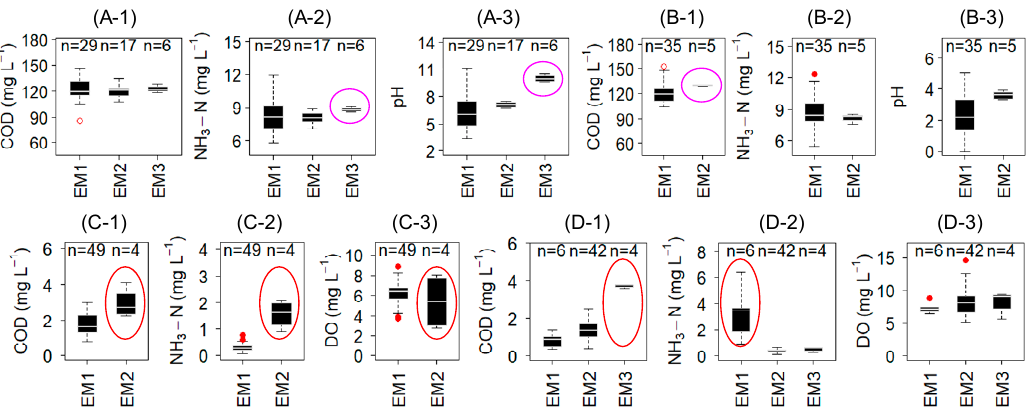
Figure 8. EM clustering classifications of discharge weeks of the YRB heavily polluted sewage outlets in the HPZ (heavily polluted zone) based on the weekly means of COD, NH 3 -N, and pH in wastewater in 2016 ( A 1–3, EM_E method) and 2017 ( B 1–3, EM_F method) and EM clustering classifications of monitoring weeks at the HuN3 site (one of the heavily polluted surface water sections in HuN province) based on the weekly means of COD, NH 3 -N, and DO in surface water in 2016 ( C 1–3, EM_SC method) and 2017 ( D 1–3, EM_SD method) (a lowercase n in Figure 8A2–4